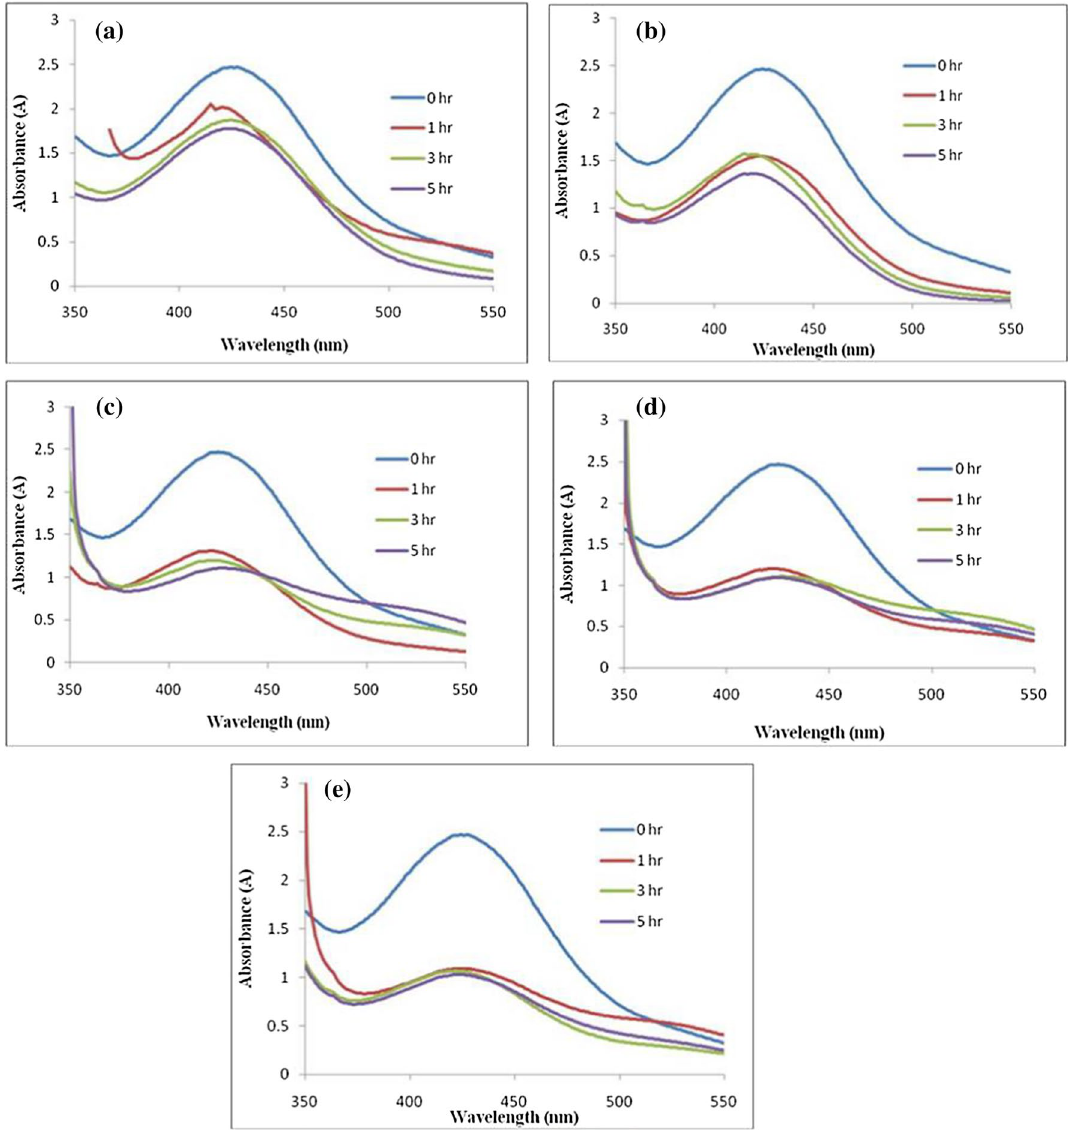
Fig. 7 UV/Vis spectra of AR photodegraded by a pure Nylon b 2%NPs/Nylon 6/6 c 10% NPs/Nylon 6/6 d 20%NPs/Nylon 6/6 e 30% ZnO/Nylon